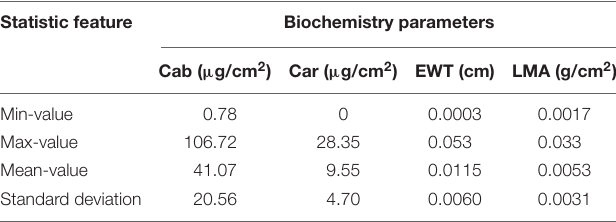
TABLE 1 | The statistic features for each parameter for two experiment databases. Statistic feature Biochemistry